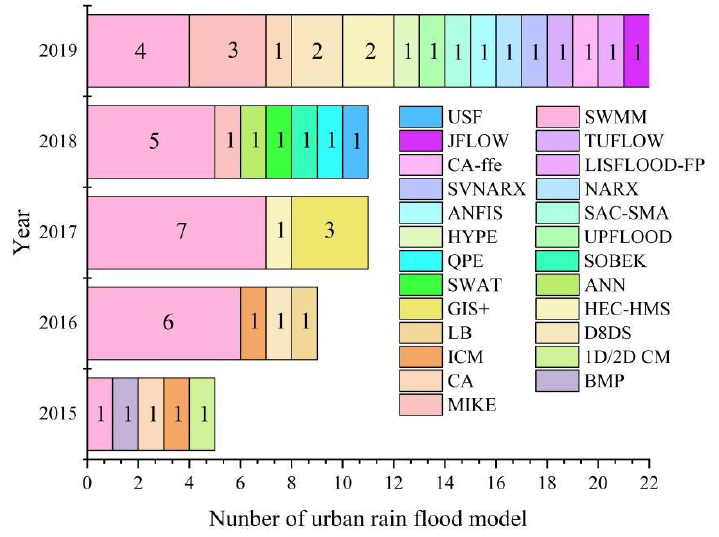
Figure 4. Number of occurrences of urban flood model.